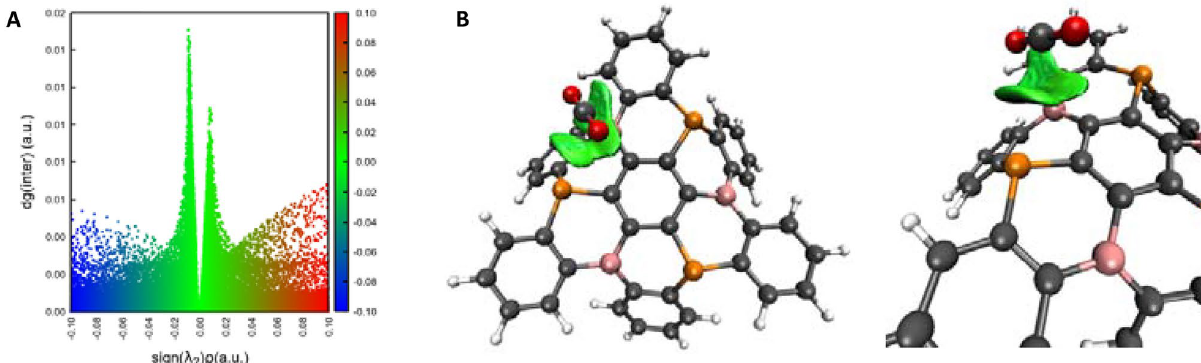
Figure 6. IGMPlot results of (B 3 P 3 -NG):CO 2 . ( A ) 2D plot of the δg as a function of the sign(λ 2 ). Attractive interactions, Van der Waals regions, and repulsive interactions are shown in blue, green and red colours respecitvely. ( B ) Interaction surface of the CO 2 molecule with the π system of B 3 P 3